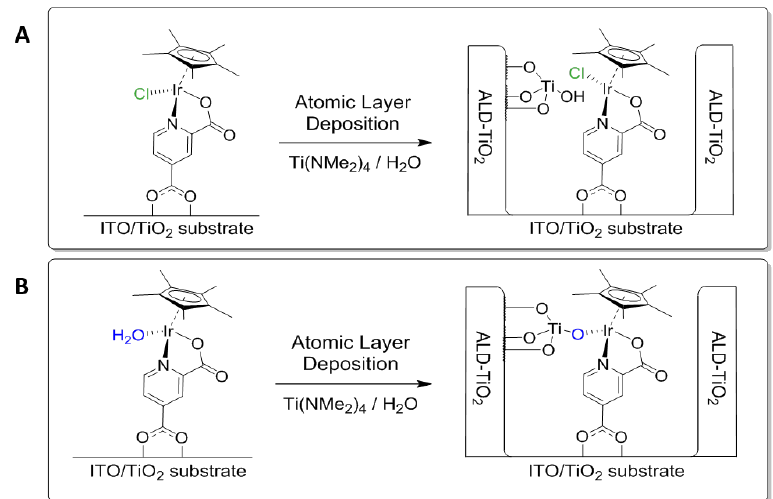
Figure 4. Reaction of anchored molecular Ir–Cl ( A ) and Ir–OH 2 ( B ) during the deposition of ALD-TiO 2 using TDMAT/water as precursors. Ir–Cl remains unchanged during ALD and is encapsulated in a TiO 2 layer, while Ir–OH 2 undergoes a reaction between the aqua ligand and the TDMAT, leading to a deactivated Ir complex embedded in TiO 2 .